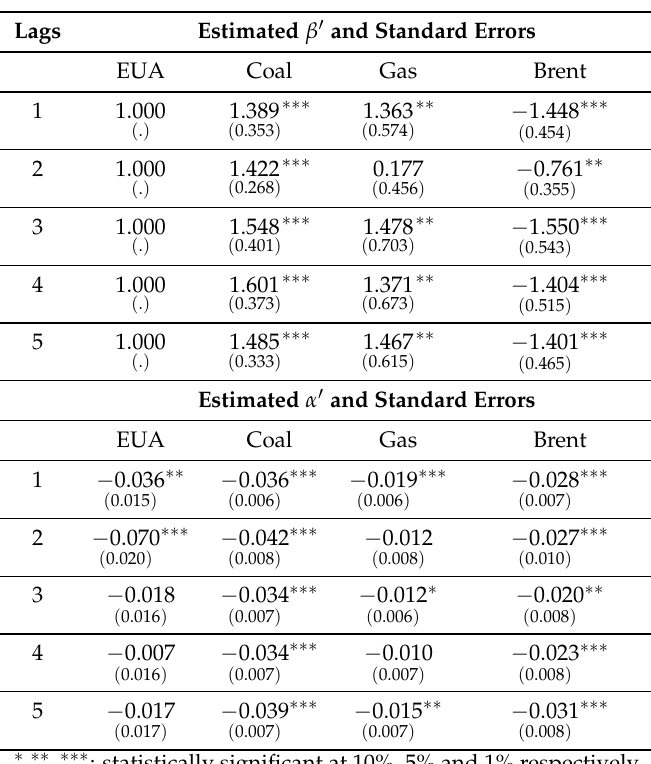
Table 5. Estimated coefficients in Equation (1) for the long- and short-run relationship ( β and α , respectively) of the weekly forward price series. Lags Estimated β (cid:48) and Standard Errors EUA Coal